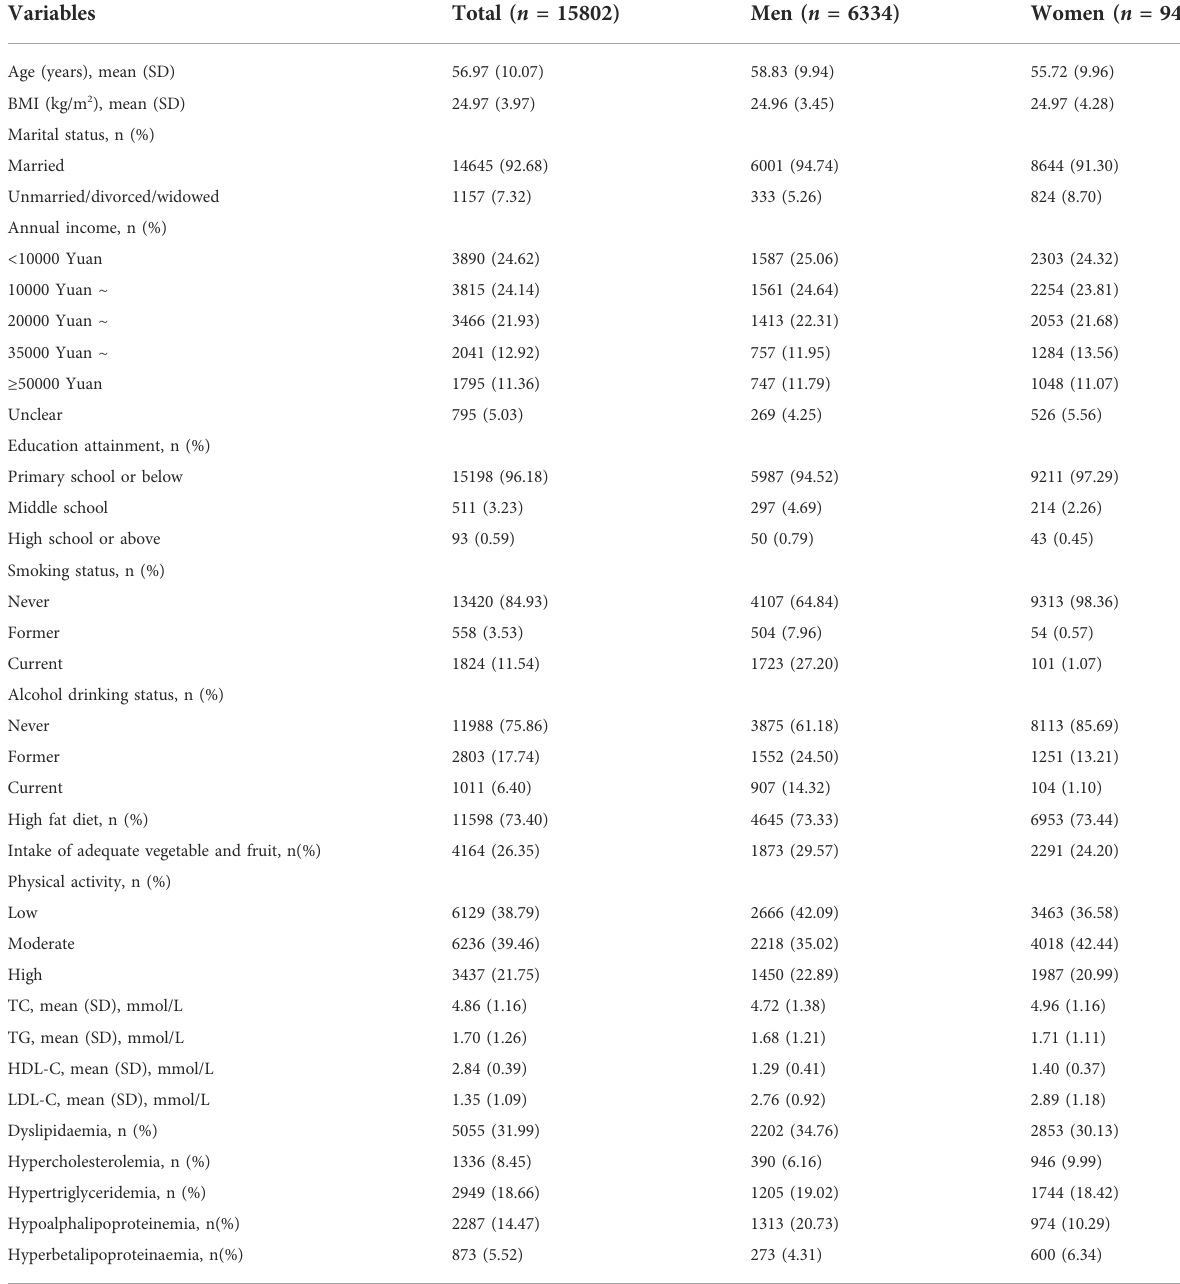
TABLE 1 Characteristics of individuals in the Ningxia Rural Study.